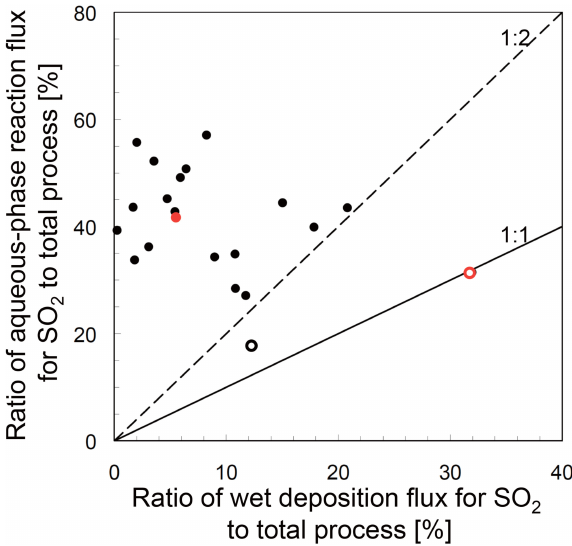
Fig. 2. Correlation of global annual mean SO 2 budgets between wet deposition fluxes (x-axis) and aqueous-phase reaction fluxes (y- axis) using model results by various CTM and GCM aerosol mod- els, in TgSyr − 1 . For reference, the 1:1 and 1:2 lines are shown as the solid and dashed lines, respectively. The closed circle in red represents the result in this study using a more physical-based sul- fur processes. The open circle in red near the 1:1 line represents the result in Takemura et al. (2000), SPRINTARS, which uses a simpli- fied sulfur process. The open circle in black represents the result in Koch et al.